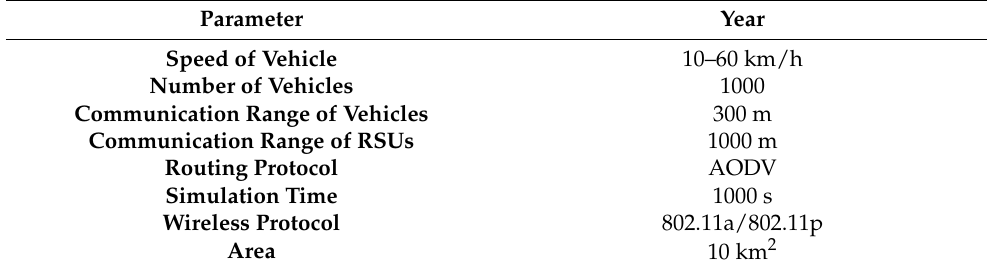
Table 4. Parameters Considered for